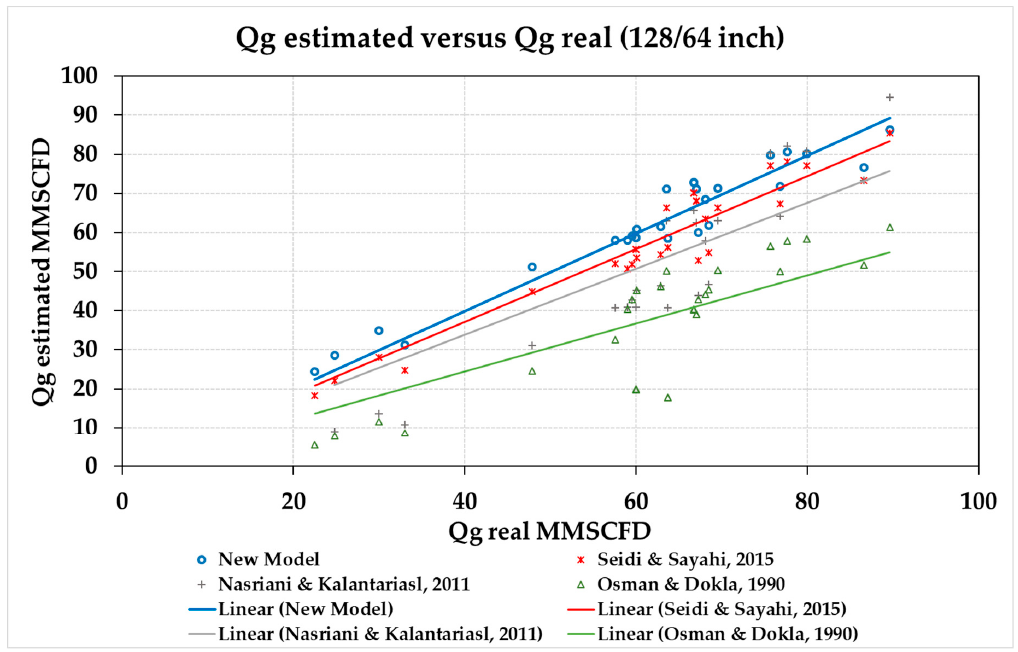
Figure 8 . Estimated gas flow rate versus real gas flow rate (128/64 inch) .